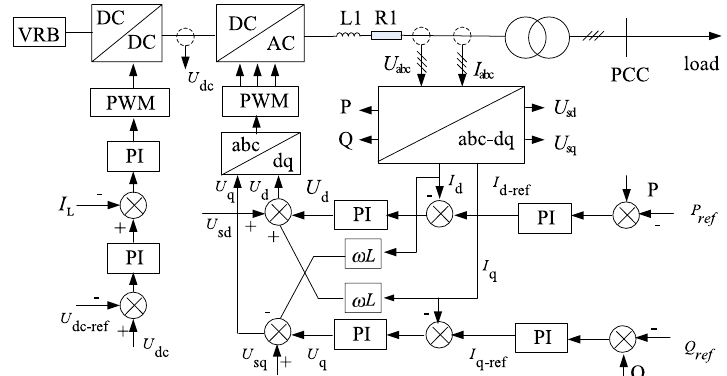
Fig. 2 Control principle of VRB energy storage system